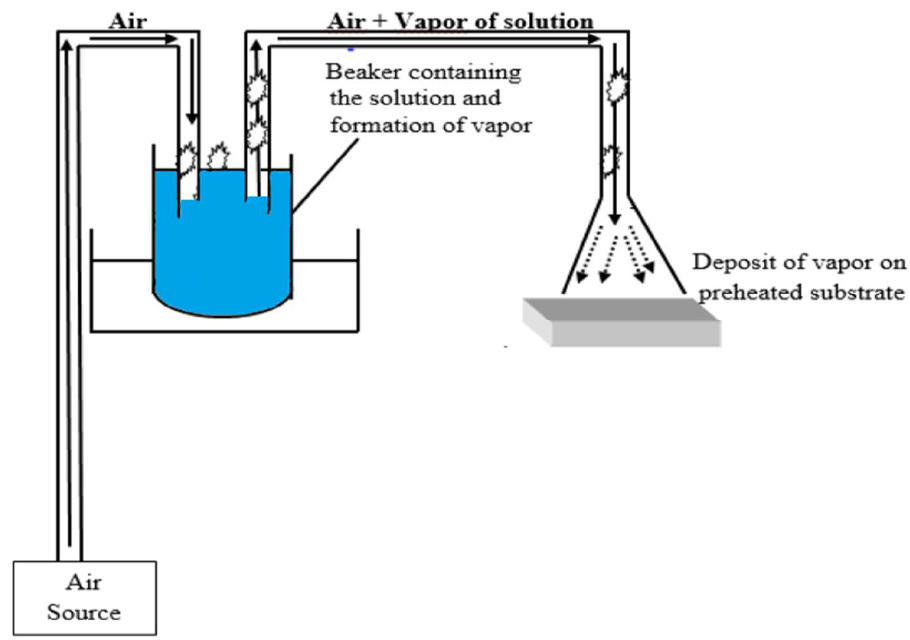
Figure 9. Principle schema of the spray pyrolysis technique.